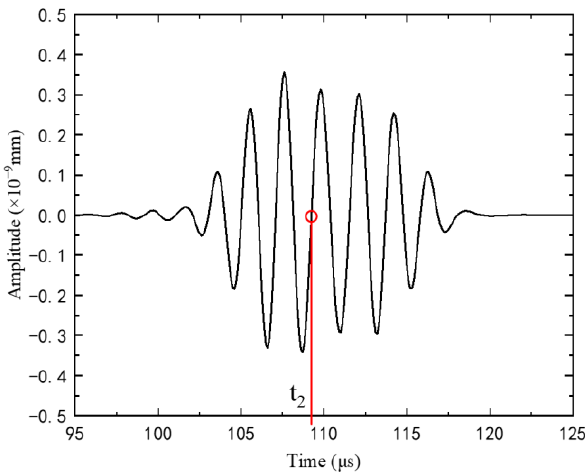
Figure 35. The central zero point of reflected wave packet (Time coordinate: t 2 ) .